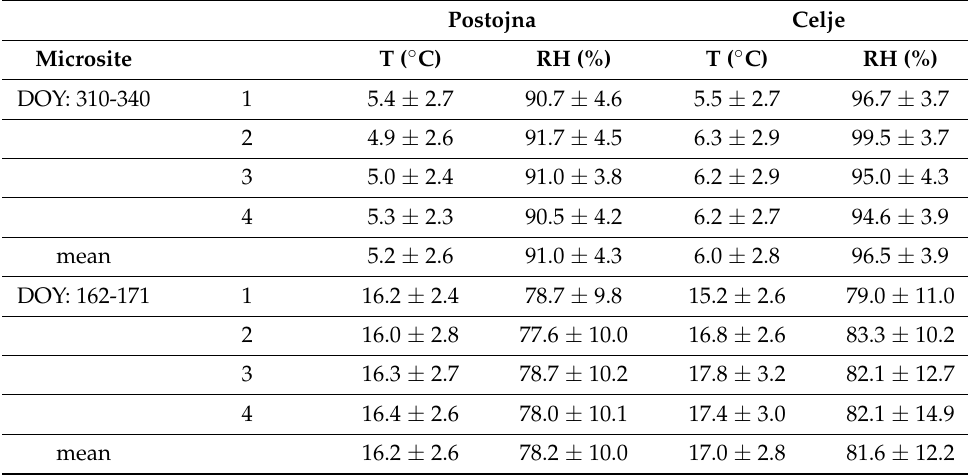
Table 3. Average temperature and humidity values for summer and late autumn microsites in Postojna and Celje. Means and standard errors are shown.